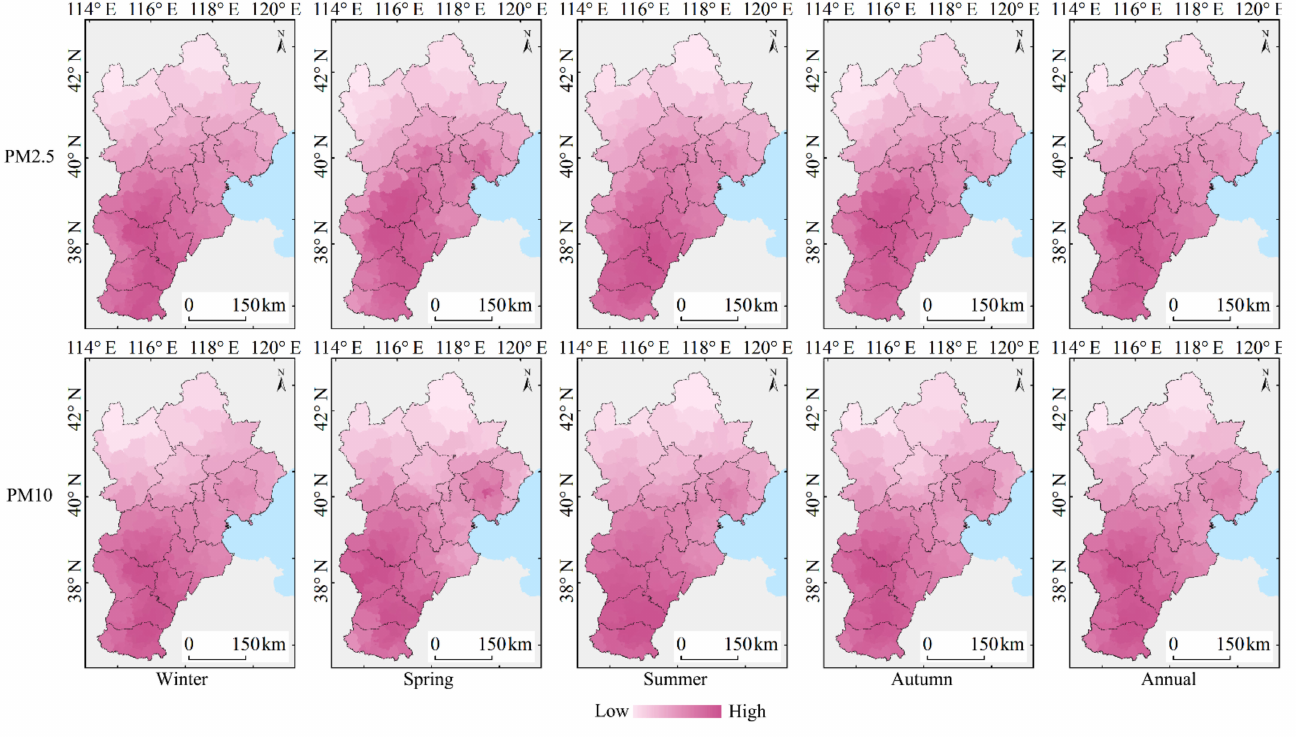
Figure 8. Spatial distributions of the PM 2.5 and PM 10 concentrations at the county